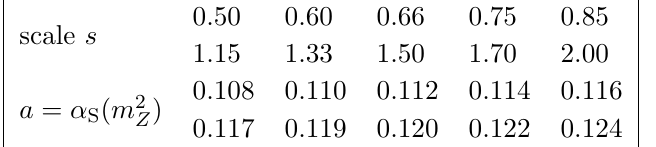
Table 1 . List of variations used for training in the example